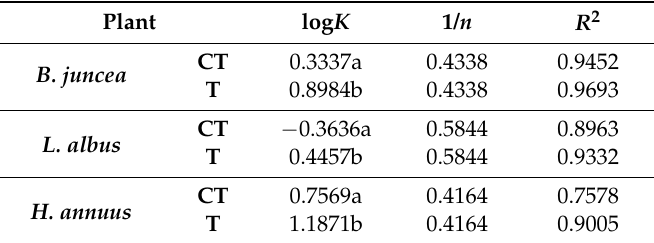
Table 2. Relationship between shoots uptake and As concentration in soil. Parameters of the Freundlich-like model by setting 1/ n as shared parameter.